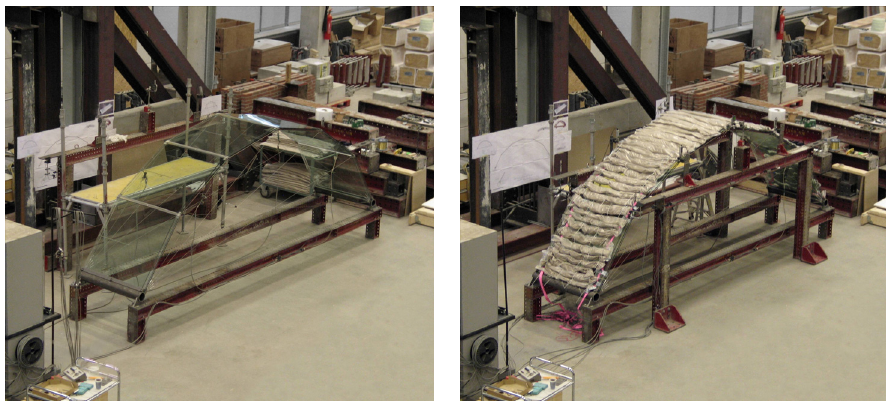
Figure 15ab: Test setup, before (left) and during (right) centric snow